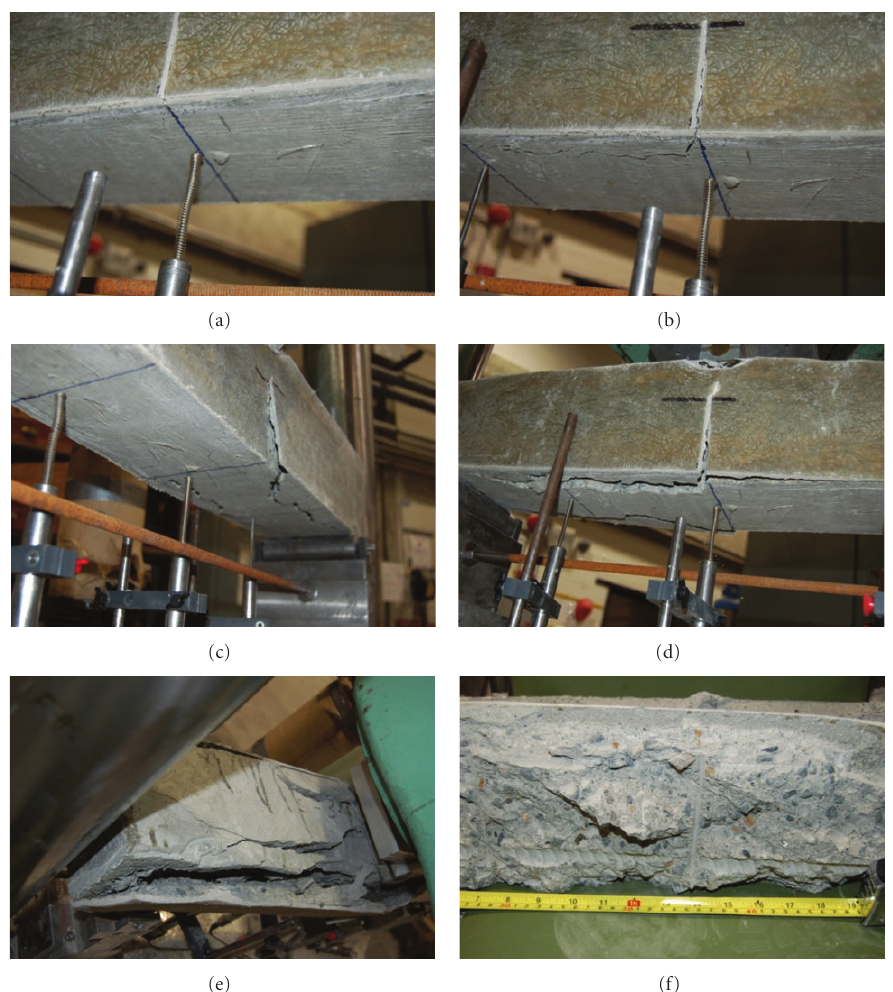
Figure 21: Beam B2-S-1. (a) to (e) Crack development under 3-point loading; (f) strong sprayed GFRP-concrete